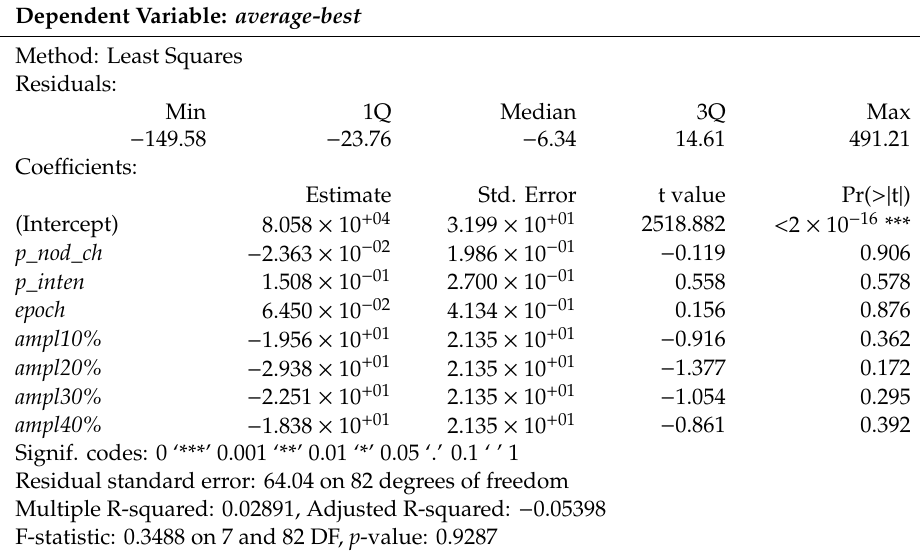
Table 2. Regression model for average-best , instance d2103 .